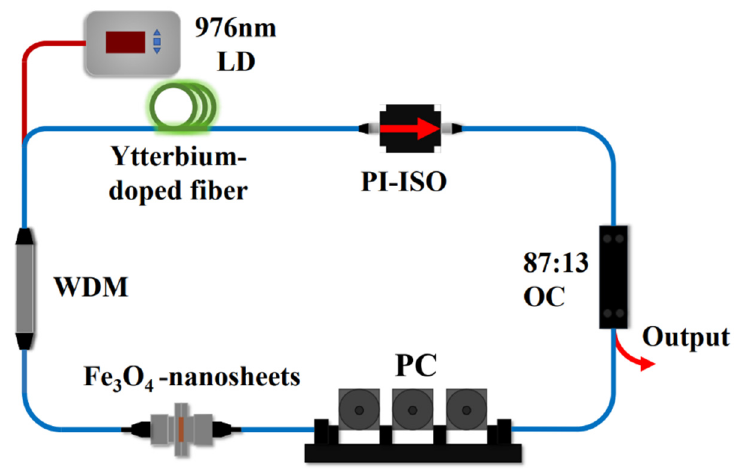
Figure 6. The experimental setup of the passively mode-locked YDFL.